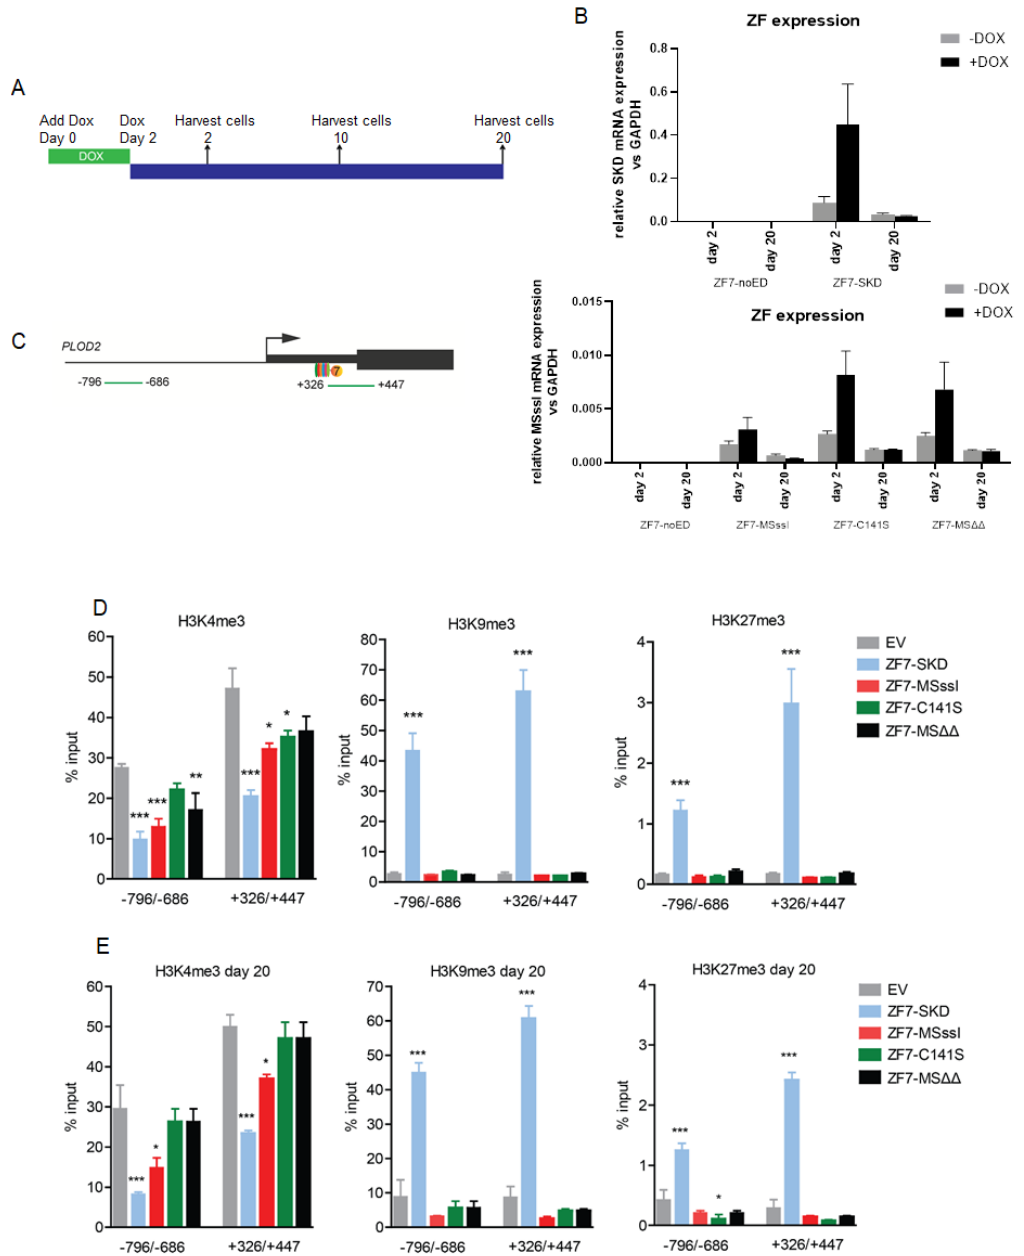
Figure 5. Targeting SKD, but not M.SssI, introduces repressive histone modifications in transgenic MDA-MB-231 cells. Expression of ZF-fusions in MDA-MB231 cells stably engineered to contain the indicated transgenes, after treatment with doxycycline for 2 days and subcultured for an additional 2 and 20 days. ( A ) Schematic representation of the experimental procedures for TET-ON MDA-MB-231 transgenic cells; ( B ) mRNA expression levels of ZF-SKD or ZF-M.SssI fusions in transgenic MDA-MB-231 cells treated with or without doxycycline for two days followed by 2 or 20 days subculturing. The specificity of the primers is indicated by the absence of expression in ZF7-NoED cells. ( C ) Schematic representation of PLOD2 with the ZF7 target site and areas detected by qChIP. ( D ) qChIP assay on transgenic cells subcultured for 2 days using antibodies against H3K4me3, H3K9me3 and H3K27me3, represented as enrichment against input DNA (mean ± SEM; n = 3, one-way ANOVA * p < 0.05, ** p < 0.01, *** p < 0.001). ( E ) qChIP assay on transgenic cells subcultured for 20 days using antibodies against H3K4me3, H3K9me3 and H3K27me3, represented as enrichment against input DNA (mean ± SEM; n = 3, one-way ANOVA (* p < 0.05, ** p < 0.01, *** p <